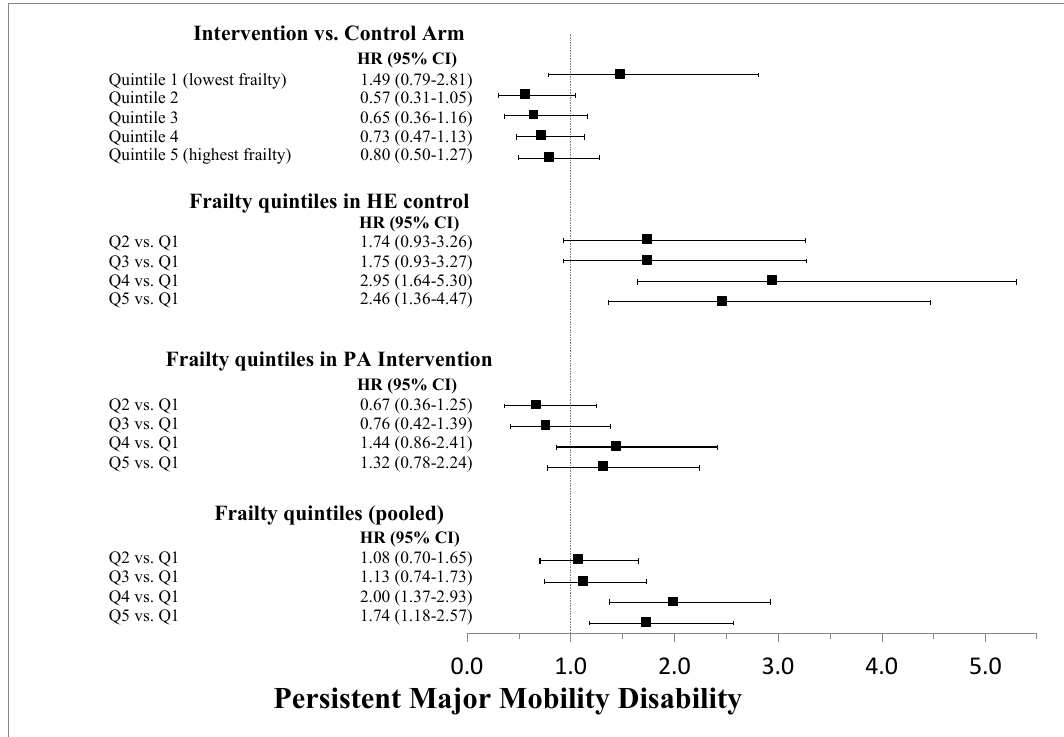
Figure 5. Cox proportional hazard regression results for the interaction between the LIFE Study intervention and quintile stratification of the frailty index for persistent major mobility disability. The topmost results compare the physical activity (PA) intervention versus the health education (HE) control arm stratified by frailty quintiles. The stratified and pooled associations of the quintiles are also shown.